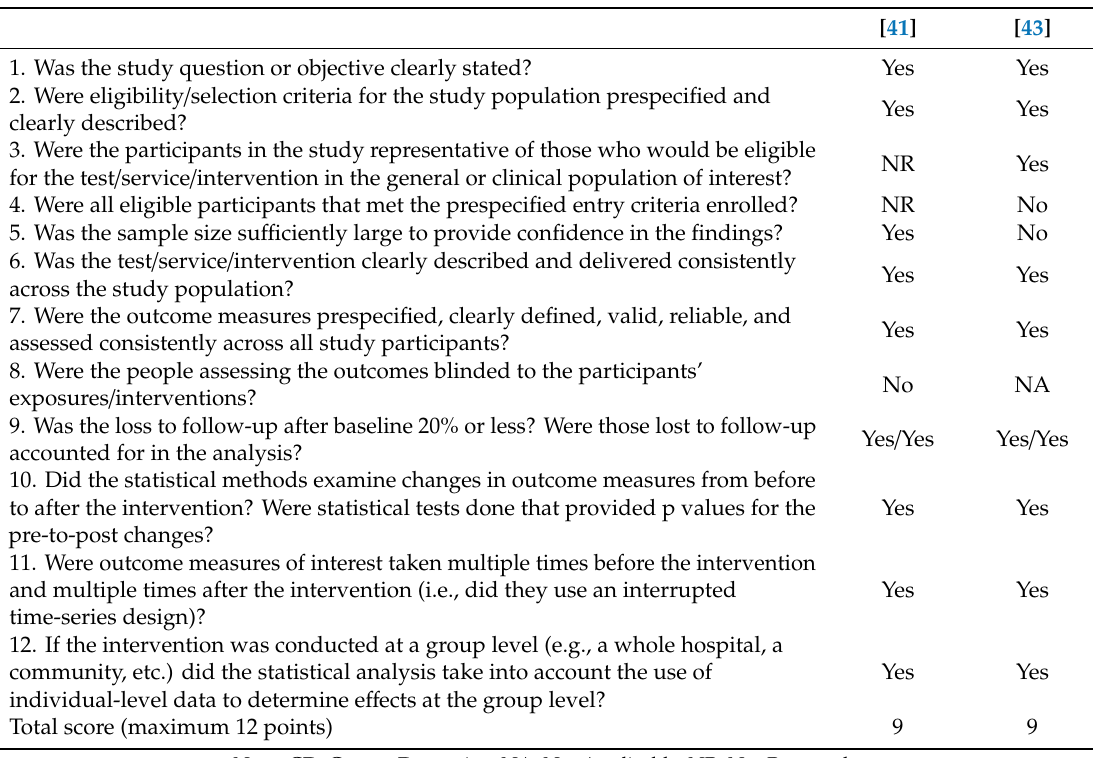
Table 5. Quality assessment of before–after